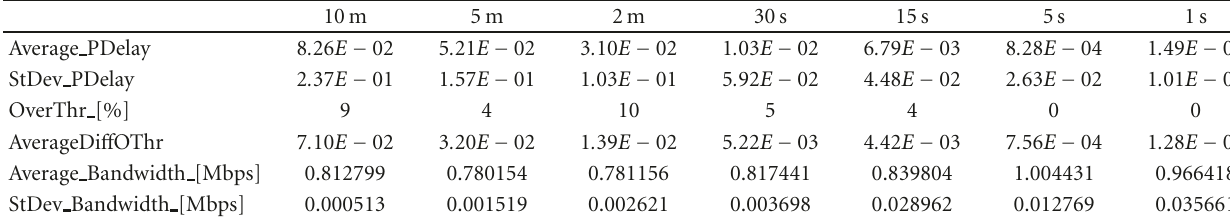
Table 2: Variable OHs for RCBC in Table